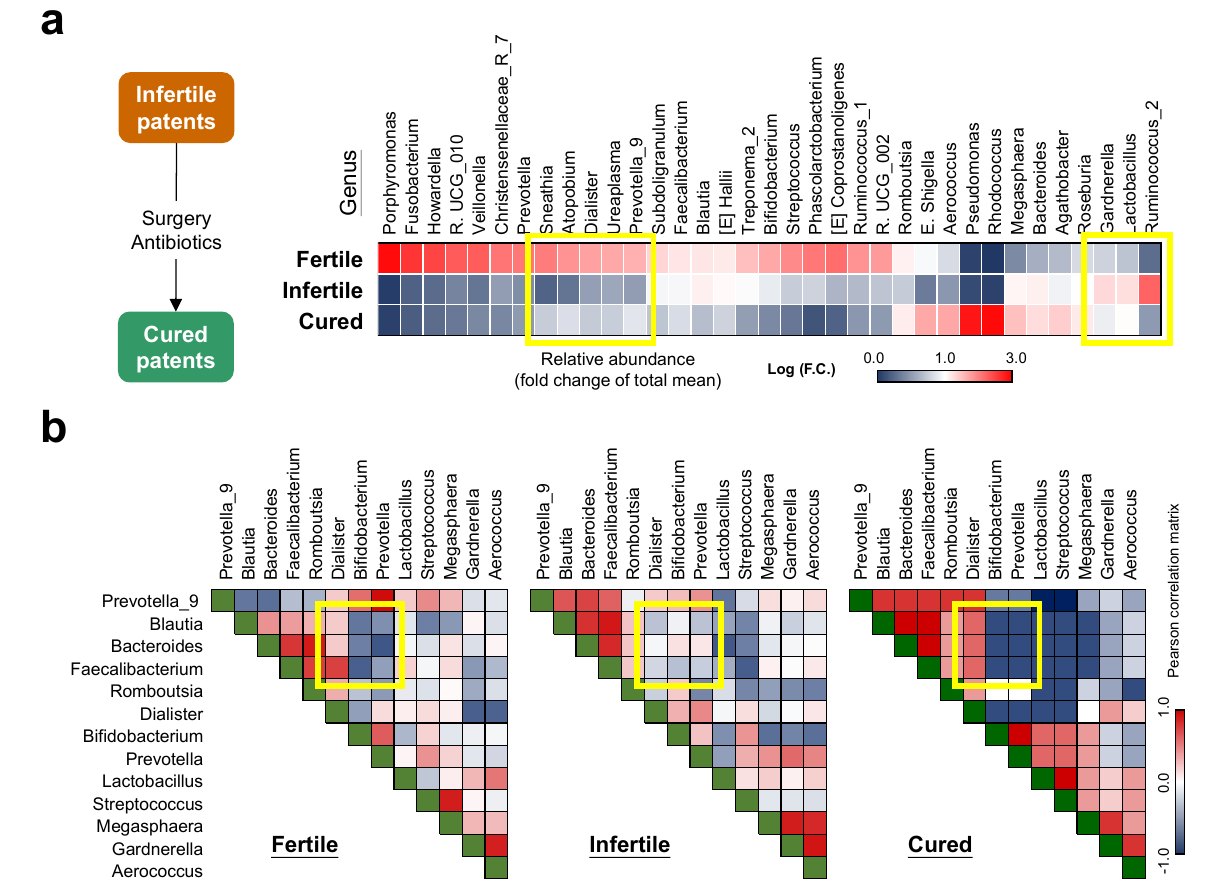
Figure 7. Ecological relationship of bacterial community in cervical mucus in endometriosis patients with different reproductive ability. ( a ) The heatmap reveals relative abundance of genera that show statistical differences between fertile and infertile patients by t-test ( p < 0.05). Yellow boxes indicate the genera that show consistent correlation between microbial abundance and reproductive ability. ( b ) Spearman correlation matrices reveal inter-genus long-term drifts of cervical microbiomes from patients with different reproductive ability .